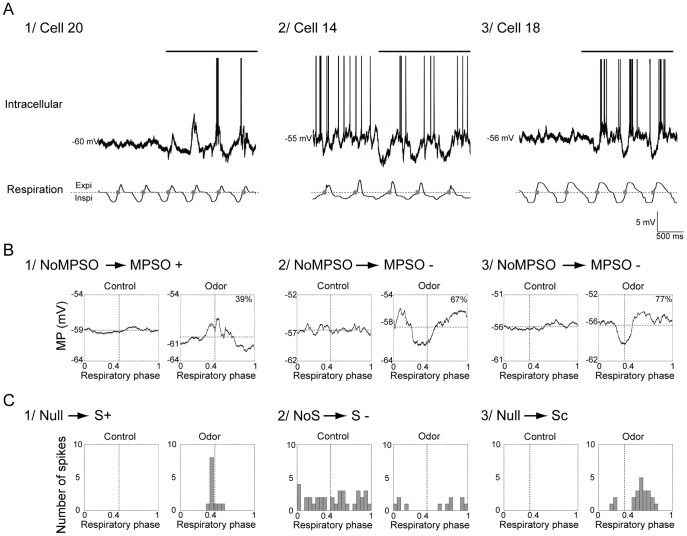
Examples of intracellular activities: membrane potential slow oscillations (MPSOs) and respiration-related discharge patterns.
A) Typical recordings of intracellular signals. Cell numbers were extracted from the matrix presented in panel B of Figure 2. Top: intracellular recording; bottom: respiratory signal with expiration (Expi) and inspiration (Inspi) separated by a dotted line. The gray circles mark the inspiration/expiration transitions. The horizontal black line at the top of the intracellular signal indicates odor stimulation. The action potentials were truncated to improve the visibility of the membrane potential. The intracellular recordings were obtained without a stabilizing current in 1 and 3 and with a −0.15 nA stabilizing current in 2. B) Respiration-triggered membrane potential averages before (Control) and during odor stimulation (Odor) of the cells presented in A. 1) A cell without membrane potential slow oscillation (NoMPSO) prior to odor stimulation acquired a positive membrane potential slow oscillation (MPSO+) during odor stimulation. 2) and 3) Cells without MPSO before odor stimulation that exhibited negative membrane potential slow oscillation (MPSO-) during odor stimulation. A vertical dotted line indicates the transition between inspiration and expiration, and a horizontal dotted line represents the mean membrane potential. The up-point proportion is indicated for each averaged MPSO in the right corner. C) Respiration-triggered histograms of the action potentials from the cells presented in panel A before (Control) and during odor stimulation (Odor). 1) A cell without an action potential (null pattern) prior to odor stimulation exhibited an excitatory-simple-synchronized pattern (S+) during odor stimulation. 2) A cell exhibiting a non-synchronized discharge pattern (NoS) in the control condition acquired a suppressive-simple-synchronized discharge pattern (S-) during odor stimulation. 3) A cell with a null pattern during the control period manifested a complex synchronized discharge pattern (Sc) during the odor period. The vertical dotted line indicates the inspiration/expiration transition.